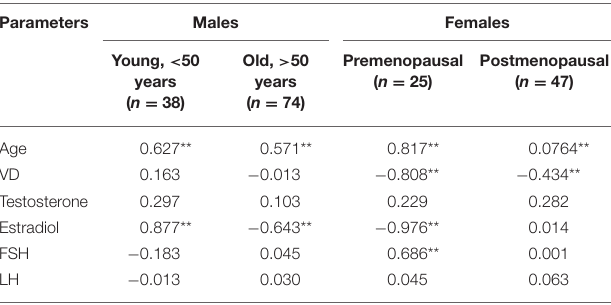
TABLE 7 | Correlation ( r values) of various investigated parameters with the stage of CRC. Parameters Males